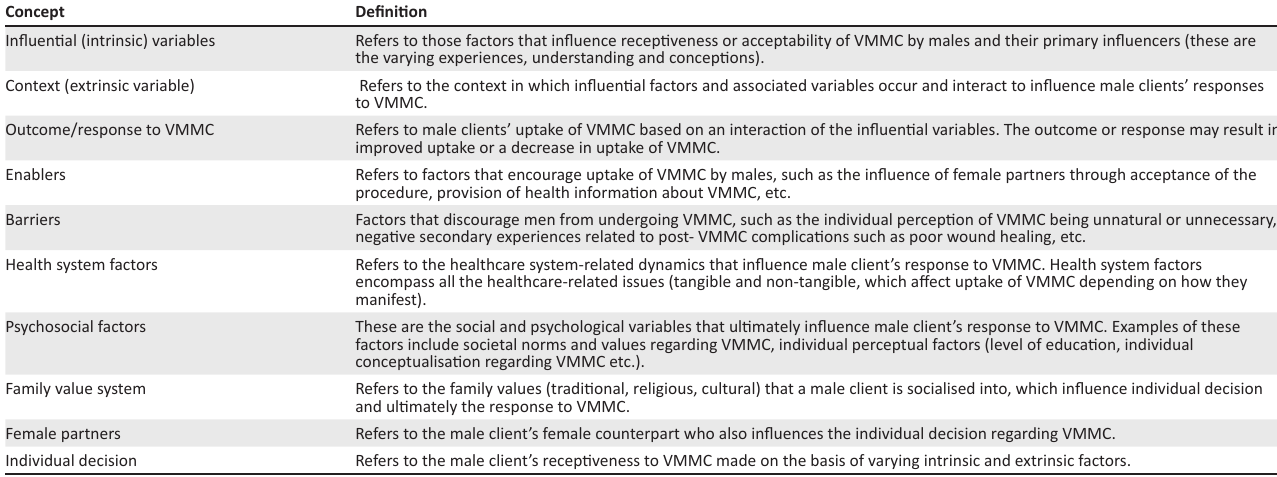
TABLE 1: Definition of key concepts in the model.